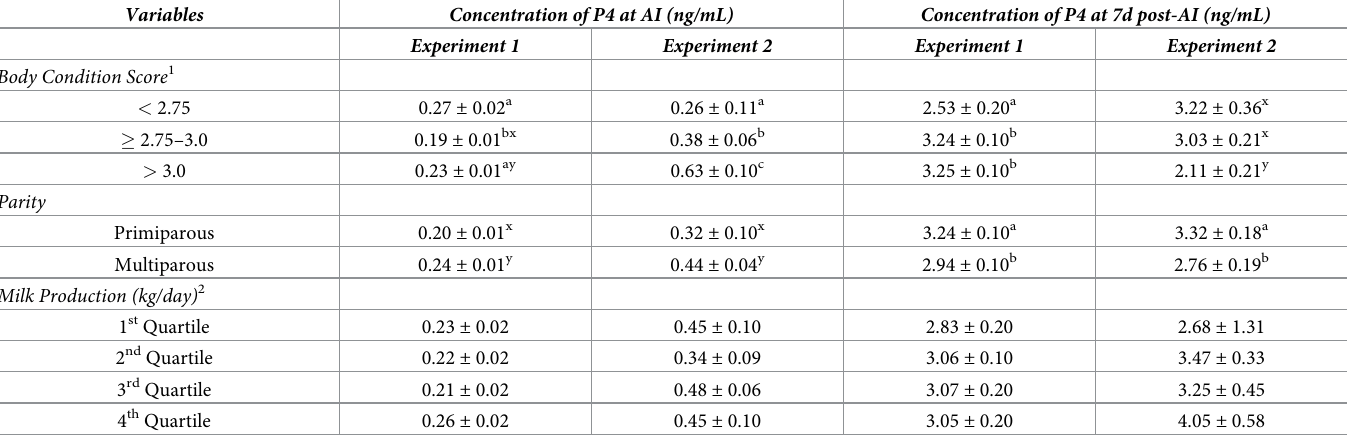
Table 2. Concentration of progesterone (least squares means ± SE) at AI and at 7 d post-AI, according to body condition score, parity and milk production on both Experiment 1 and Experiment 2.